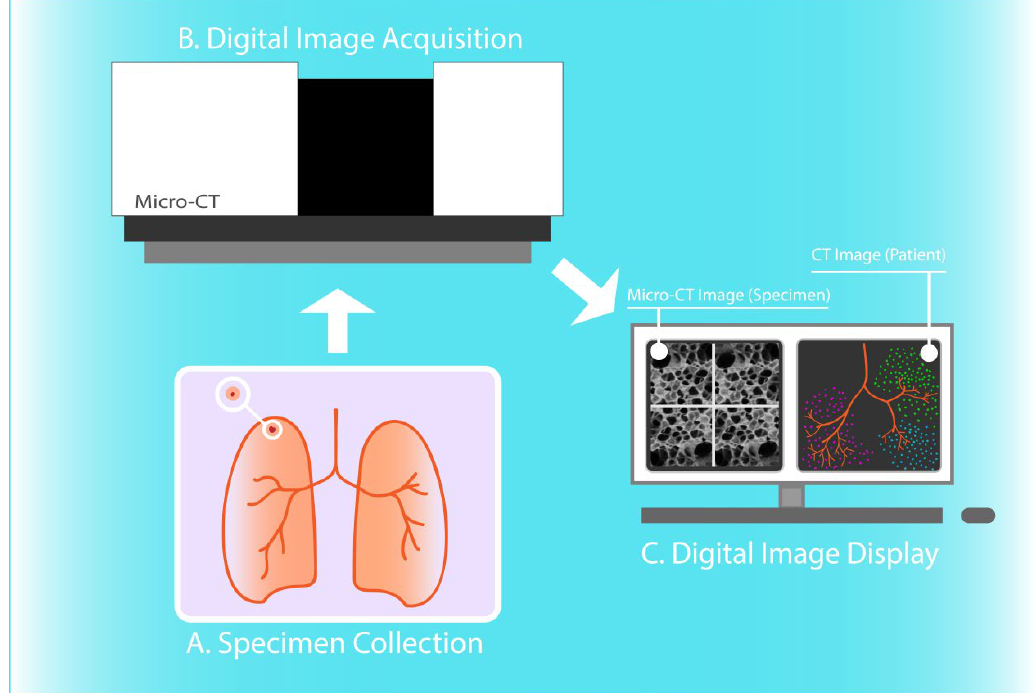
Figure 3. Micro-CT imaging of human lung tissue specimens. Resected lung tissue specimen ( A ) is scanned through micro- computed tomography (micro-CT) scanner ( B ) and 3D images of high spatial resolution are generated after reconstruction ( C ). Herein, 3D micro-CT images of terminal bronchioles and pulmonary acini are displayed ( C left ), in comparison with illustrated CT-derived low attenuation cluster analysis of the airway tree ( C right ).